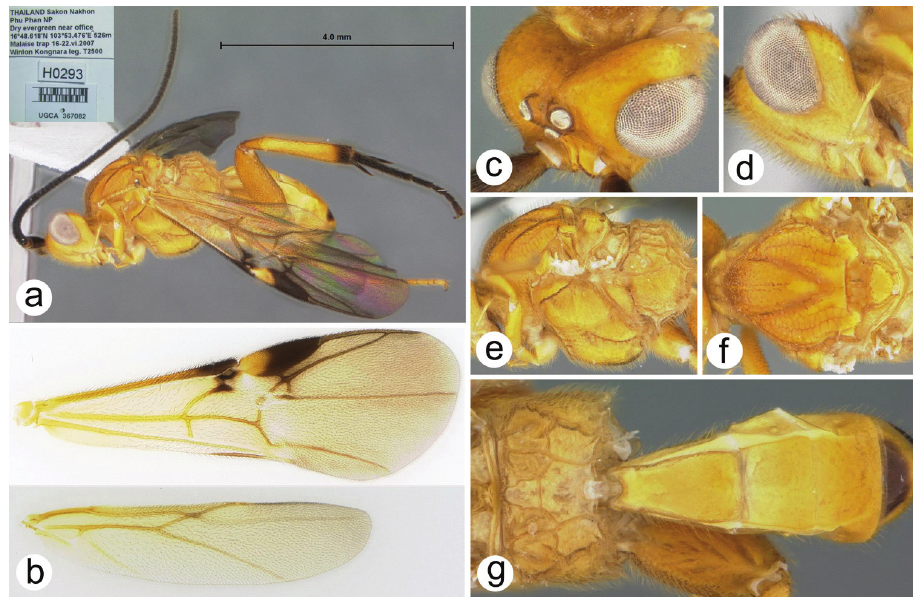
Figure 17. Zelodia suyaneeae sp.n. a lateral habitus b wings c dorsal head d dorsolateral head e lateral mesosoma f dorsal mesosoma g dorsal propodeum and